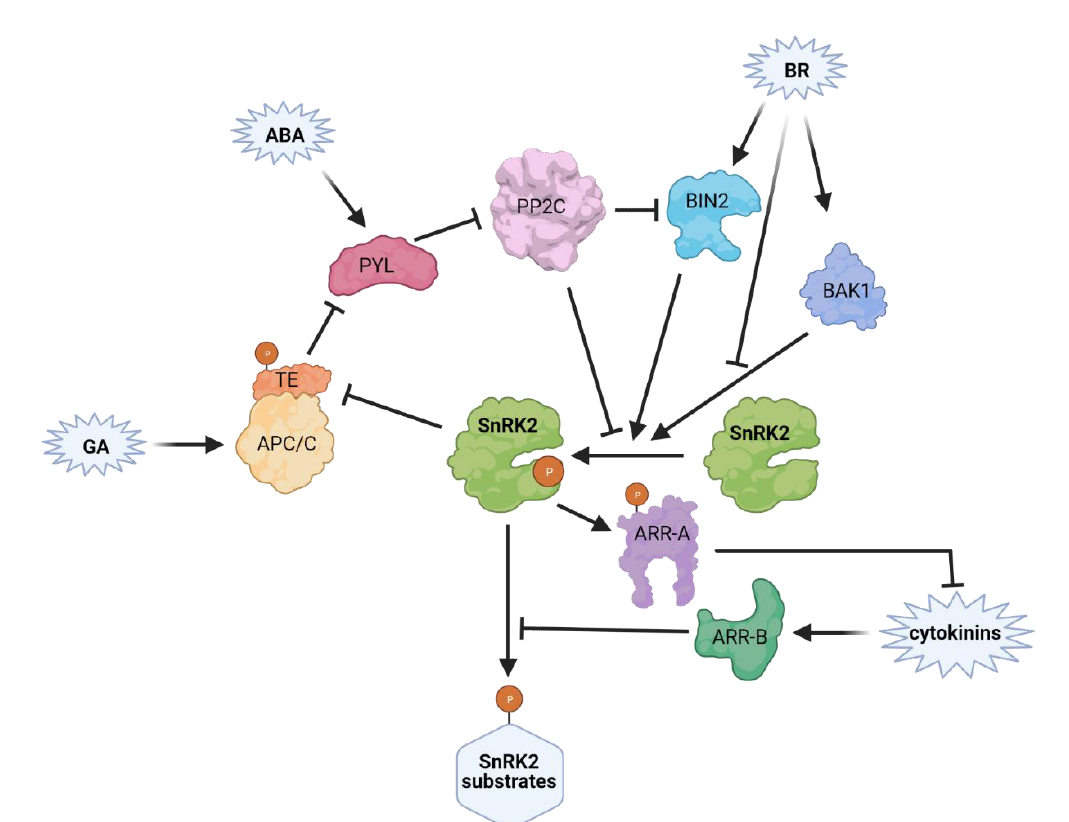
Figure 5. Plant hormones in SnRK2 regulation. Lines with arrowheads indicate positive regulation, bar-ended lines indicate inhibition. SnRK2 activity is impacted by abscisic acid (ABA), brassinosteroid (BR), giberellin (GA) and cytokinin signalling pathways and crosstalk between those hormones. BRASSINOSTEROID INSENSITIVE 2 kinase (BIN2), a negative regulator of BRs signaling, phosphotylates SnRK2.2 and 2.3 and enhances their activity. In the absence of ABA, group 3 SnRK2s and BIN2 are inhibited by clade A type 2C protein phosphatases (PP2Cs). In the presence of ABA, the hormone binds to PYRABACTIN RESISTANCE 1/PYR1-LIKE/REGULATORY COMPONENTS OF ABA RECEPTOR (PYLs) which interact with and inhibit PP2Cs. BR co-receptor BRASSINOSTEROID INSENSITIVE1-ASSOCIATED RECEPTOR KINASE 1 (BAK1) through SnRK2.6 phosphorylation induces ABA-dependent stomatal closure, whereas BRs negatively regulate BAK1/SnRK2.6 complex formation. Positive regulators of cytokinin signaling, Type-B Arabidopsis response regulators (ARRs; namely ARR1, ARR11, and ARR12) interact with and inhibit SnRK2.6 activity. On the other hand, a negative regulator of cytokinin signalling, Type-A ARR (ARR5), is stabilized through phosphorylation catalysed by SnRK2s. The link between GA and ABA pathways relies on interaction of an activator of the E3 ubiquitin ligase complex APC/C TE —Tiller Enhancer (TE) with PYL. GA enhances the interaction, which leads to PYL degradation and reduction of the activity and protein level of group 3 SnRK2s. The presence of ABA induces TE phosphorylation by SnRK2s from group 3 and PYL dissociation from TE-PYL complex, thus preventing the GA-induced